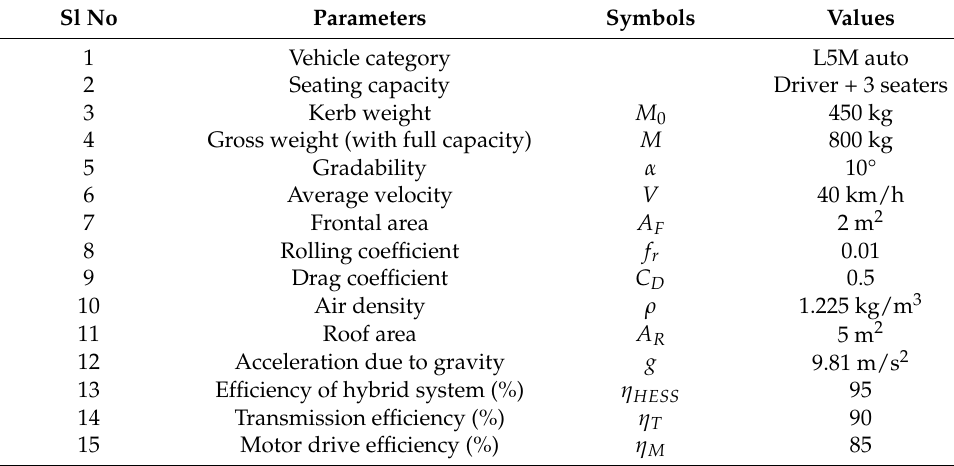
Table 1. Design parameters of electric